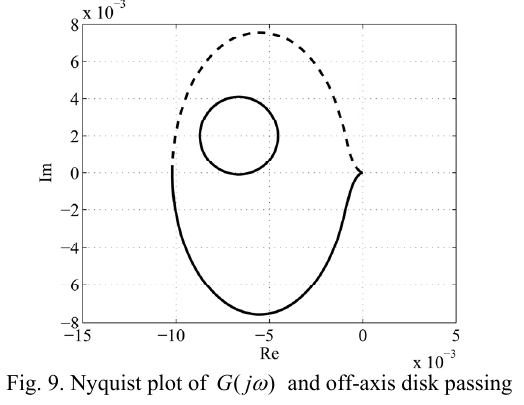
1 1 ( ,0) ( ,0) − and − . 138 166